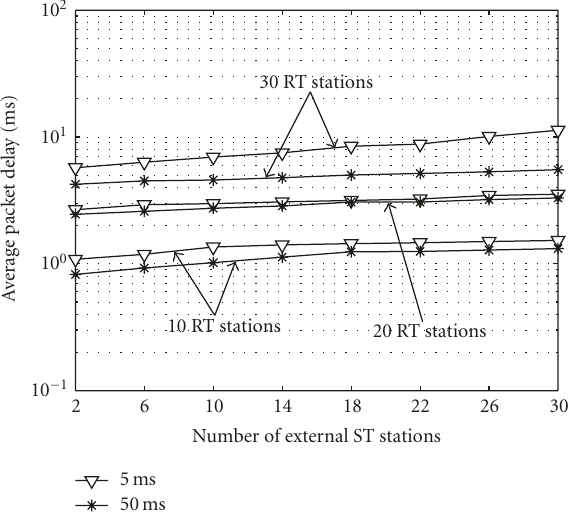
Figure 7: Average packet delay—MSP = 5ms and 50 ms.